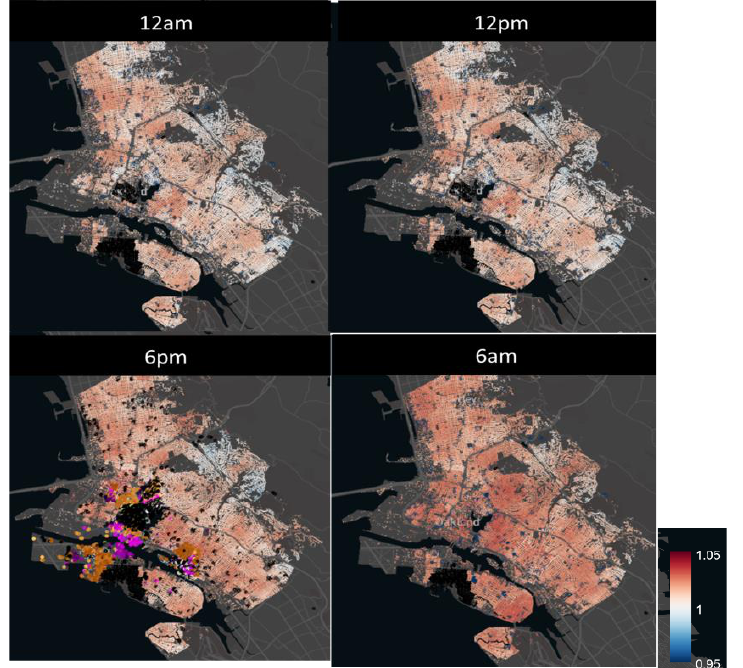
Figure 15. Scenario 3 distribution system voltages for select times of day, with voltage excursions highlighted with orange and pink dots .